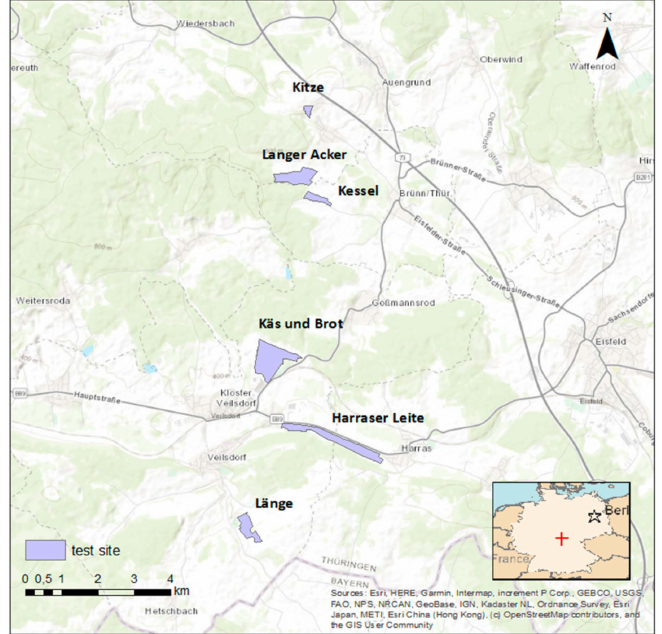
Figure 1. Study area and test sites in Germany. Kitze = 2.5 ha, Langer Acker = 17 ha, Kessel = 6 ha,